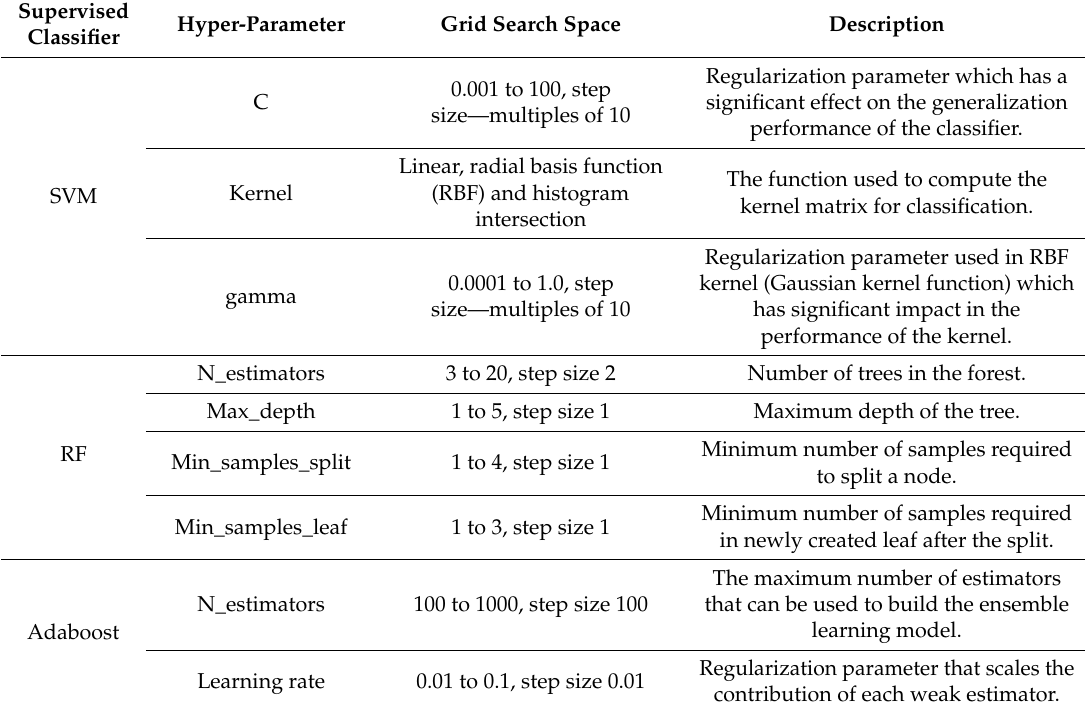
Table 2. Definition of grid search space for tuning the hyper-parameters of the